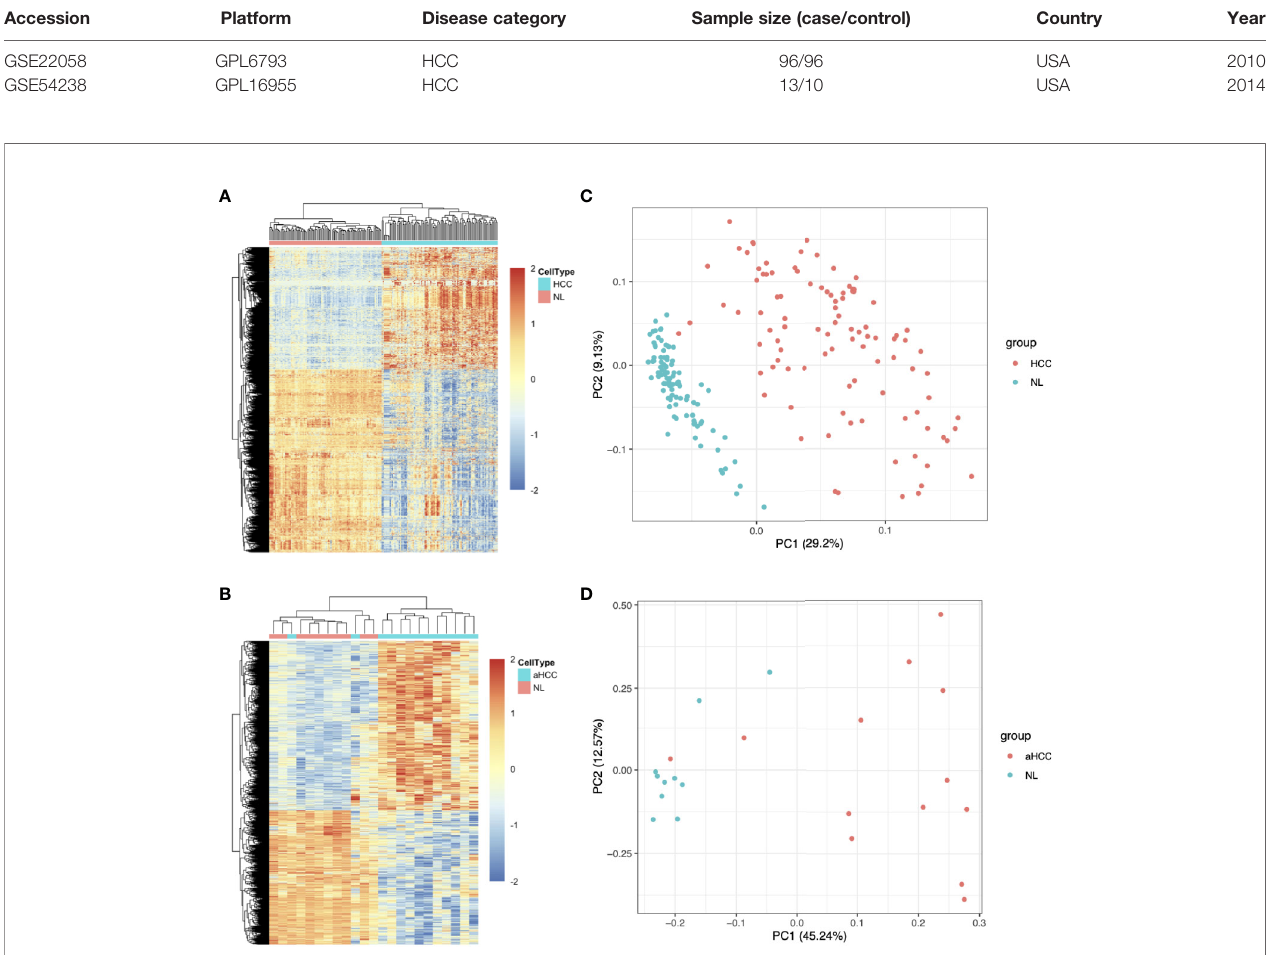
FIGURE 1 | Upregulated and downregulated DEG distribution in HCC samples based on the GSE22058 and GSE54238 datasets. (A, B) DEG hierarchical clustering analysis. All the data input represents the log 2 ratio of HCC intensity relative to the normal intensity. The red color represents markedly upregulated genes selected at p < 0.05; the blue color represents markedly downregulated genes at p < 0.05. (C, D) PCA was performed to separate HCC from nontumor samples. aHCC, advanced hepatocellular